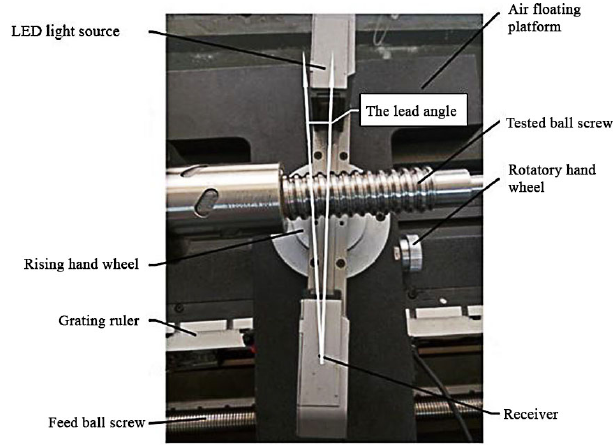
Figure 3. Details of the measurement